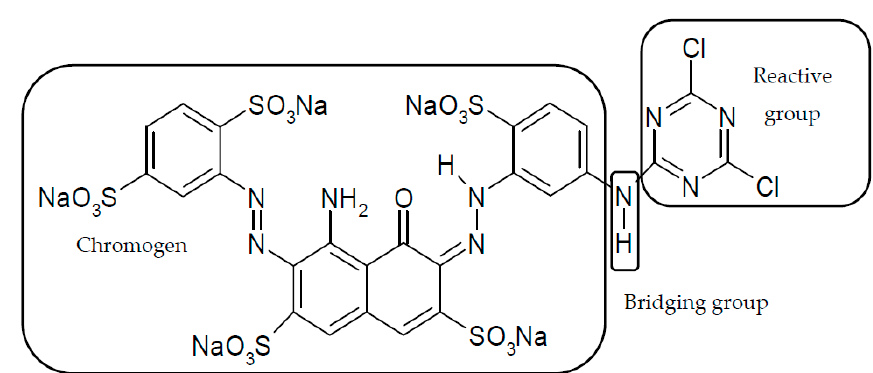
Figure 2. Molecular structure of a reactive dye—C. I. Reactive Blue 109. Reprinted from Parimal P.,